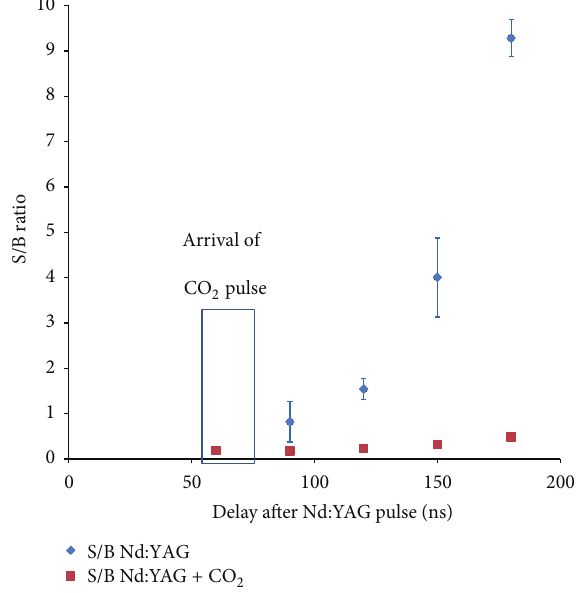
Figure 13: Effect of short-pulse CO 2 reheating pulse on CN Δ ] = 0 signal to background